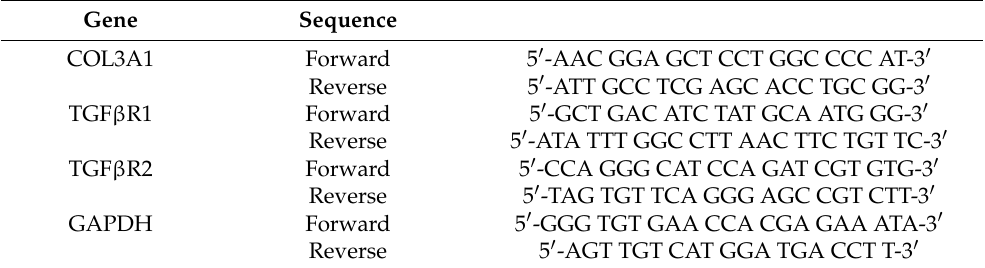
Table 2. The primer sequences for target genes used in the study.